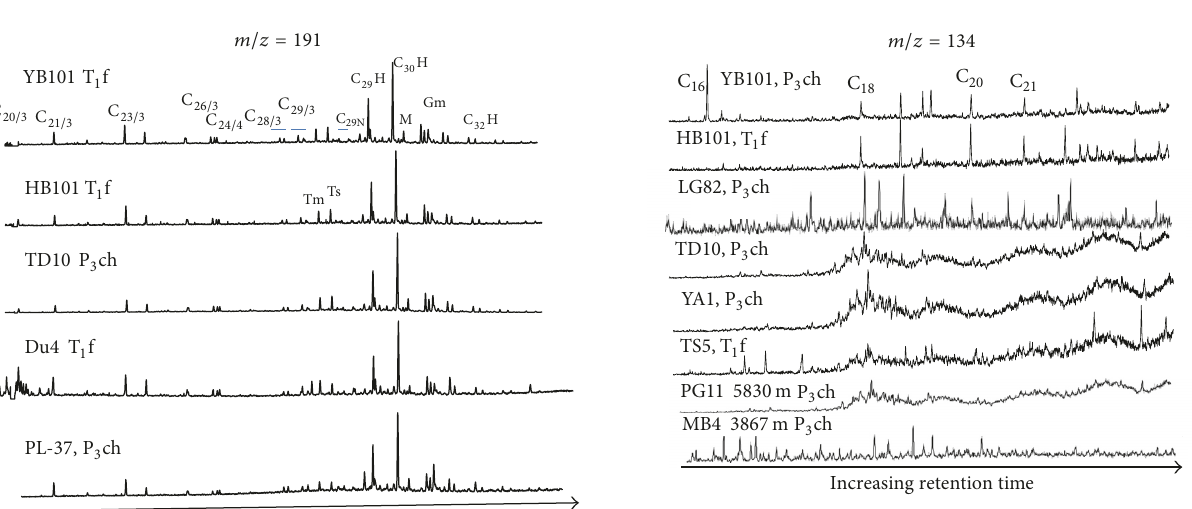
Figure 5: GC-MS selected ion mass chromatograms ( 𝑚/𝑧 134) for extractable organic matter from solid bitumen from western gas fields (wells YB101, HB101, and LG82) and eastern gas fields (wells TD10, YA1, TS5, PG11, and MB4). Abundant aryl isoprenoids are found to occur in wells in the west not in the